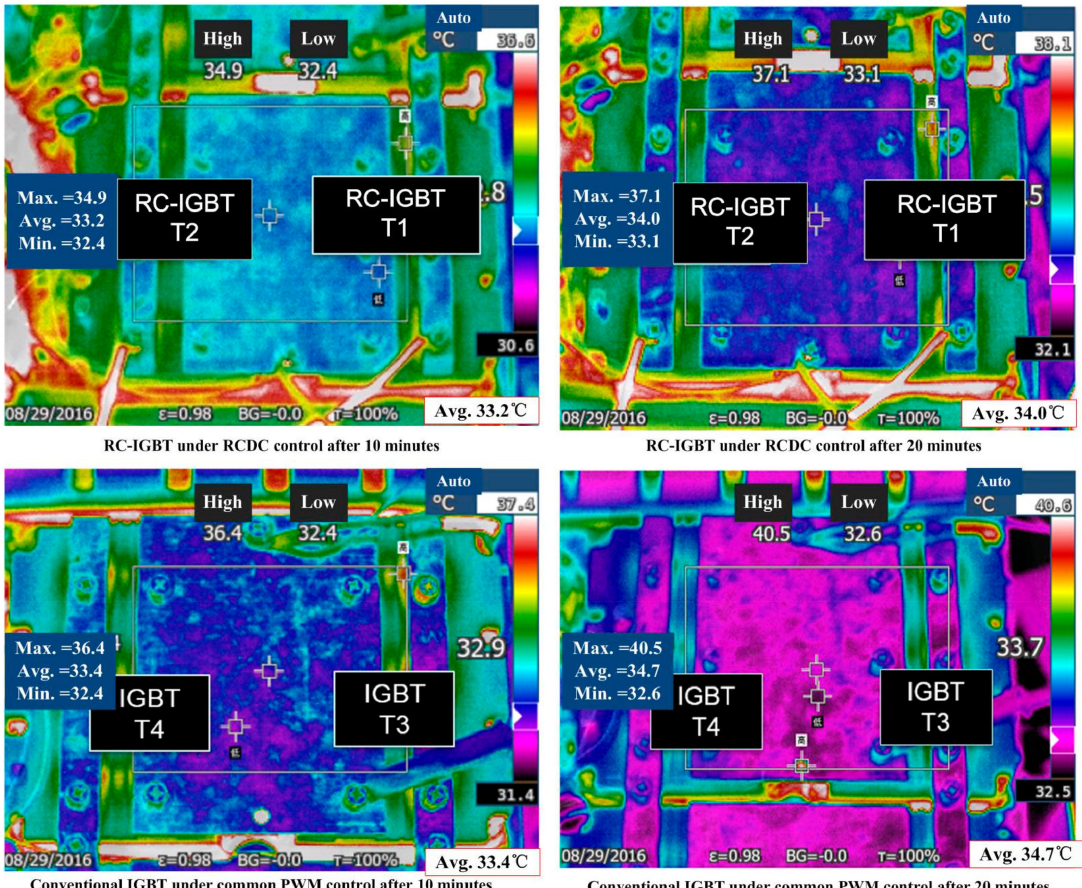
Figure 19. Images of the temperature rise of the RC-IGBT and conventional